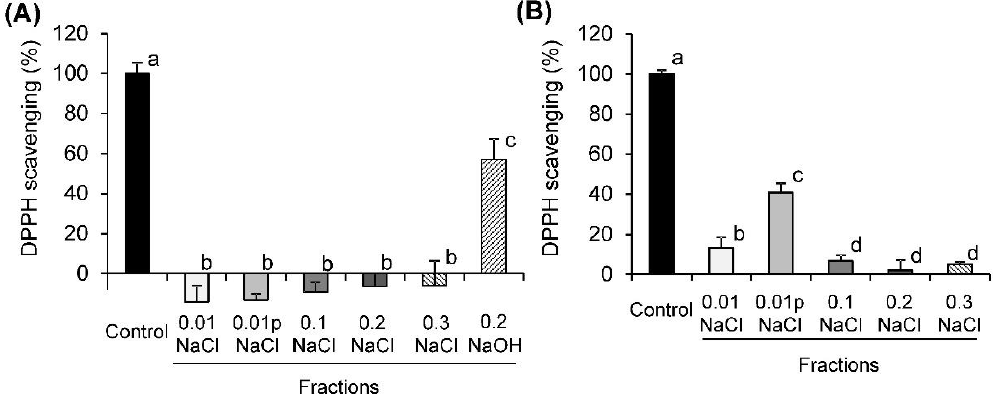
Figure 2. The DPPH scavenging activity of fractions of pectins EA-4.0 ( A ) and EA-0.8 ( B ) obtained by their fractionation on DEAE-cellulose column in comparison with the original pectin (control). Data are presented as the mean ± SD of three independent experiments. Different lowercase letters (a, b, c, d) indicate significant differences ( p < 0.05, LSD test).